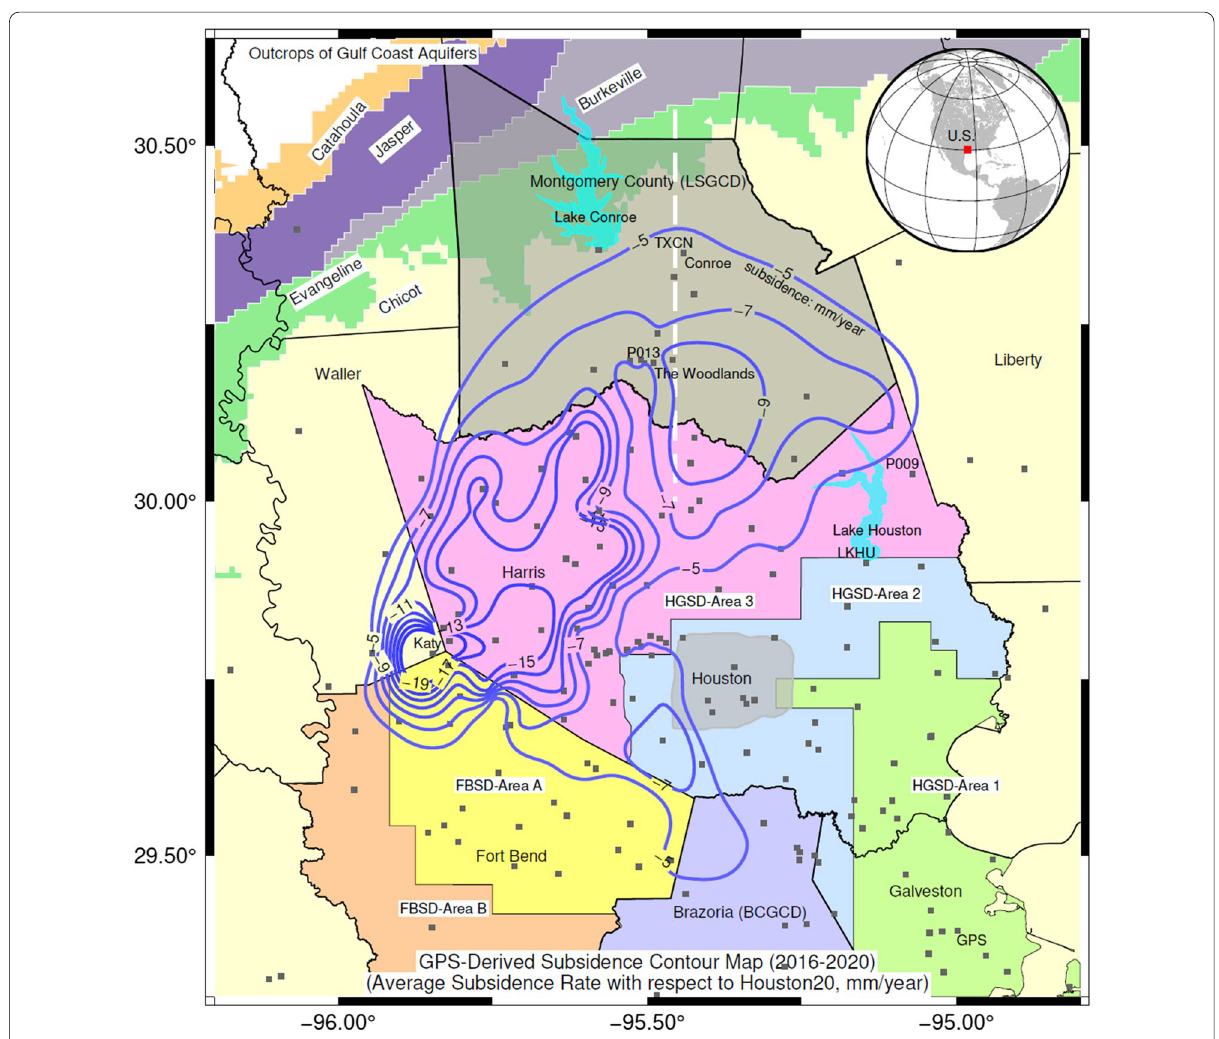
Fig. 1 Map showing the contours of average subsidence rates (2016–2020) derived from over 210 permanent GPS observations (> 3 years) within the Greater Houston region. The gray squares represent GPS sites used for creating the contour map. The subsidence rates are aligned to the Stable Houston Reference Frame (Houston20). The northwest corner of this map displays outcrops of the Gulf Coast Aquifer (Casarez 2020). The color patterns represent the areas regulated by the Harris-Galveston Subsidence District (HGSD: Areas 1, 2, 3), the Fort Bend Subsidence District (FBSD: Areas A and B), the Brazoria County Groundwater Conservation District (BCGCD), and the Lone Star Groundwater Conservation District